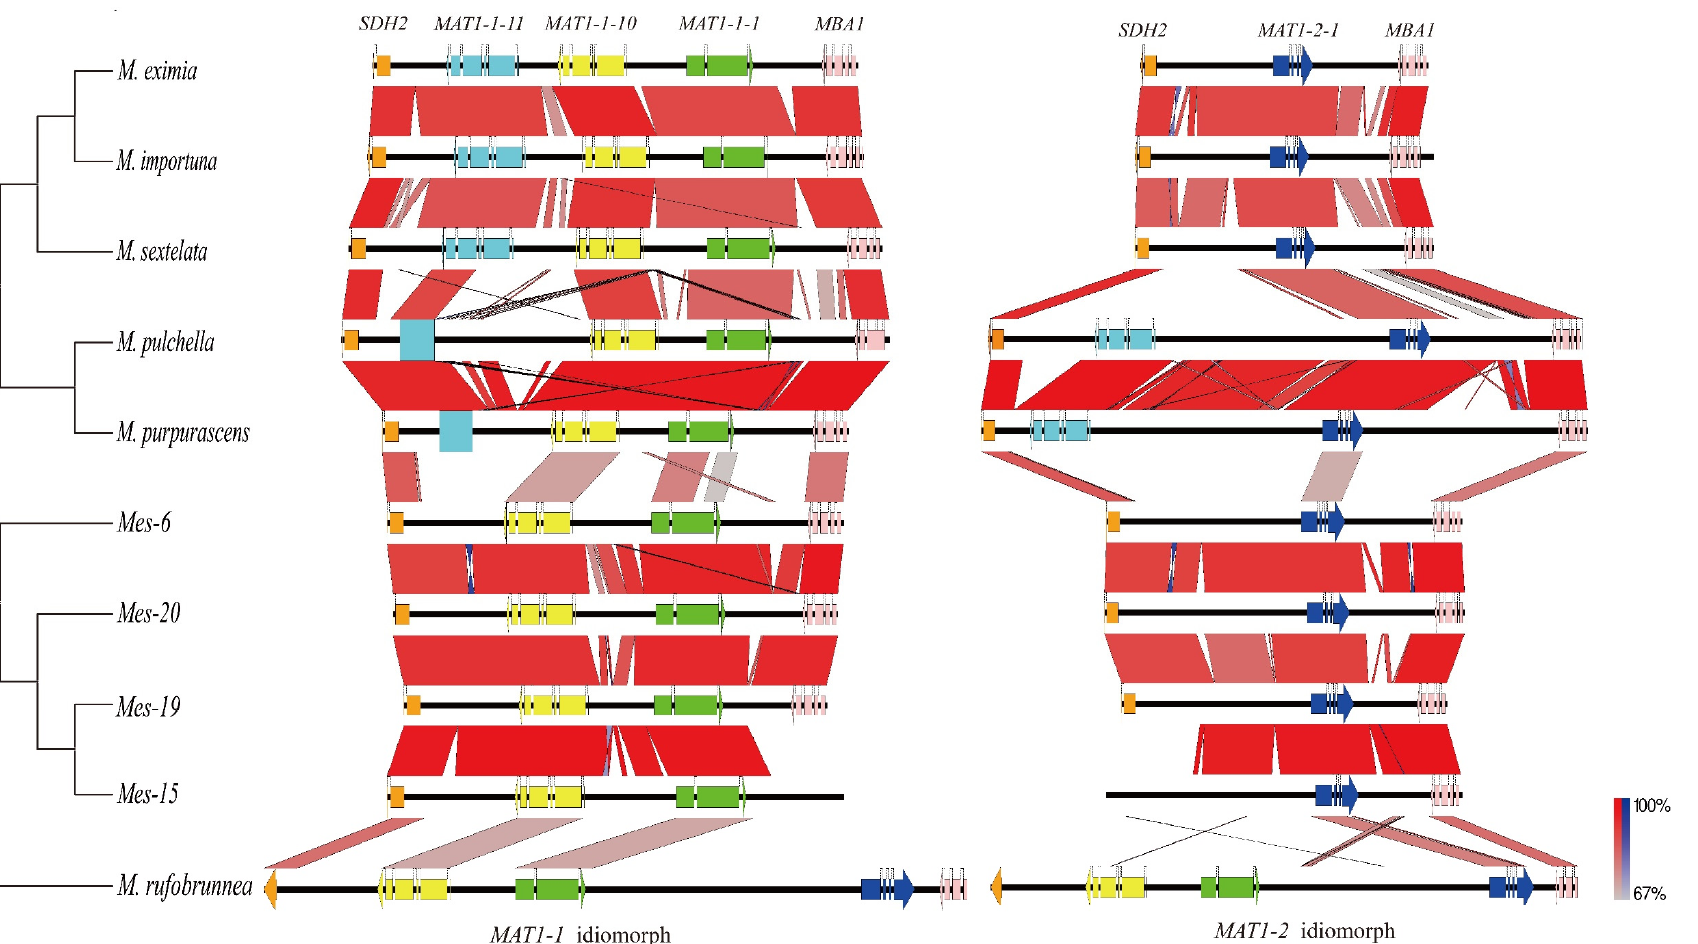
Figure 2. Pairwise comparison of the mating idiomorphs between species of Morchella . The black horizontal lines represent genomic sequences, and the color-coded arrows represent coding sequences in the forward (right-oriented arrow) or reverse (left-oriented arrow) strand. The red or blue boxes between genomic sequences indicate pairwise similarity based on BLASTn; red boxes indicate that both regions are in the same orientation, while blue boxes indicate that the regions are oriented in the opposite directions. Neighbor-joining (NJ) phylogenetic analysis between Morchella species based on a multi-locus dataset (ITS, RPB1 , RPB2 , LSU, and EF1-a